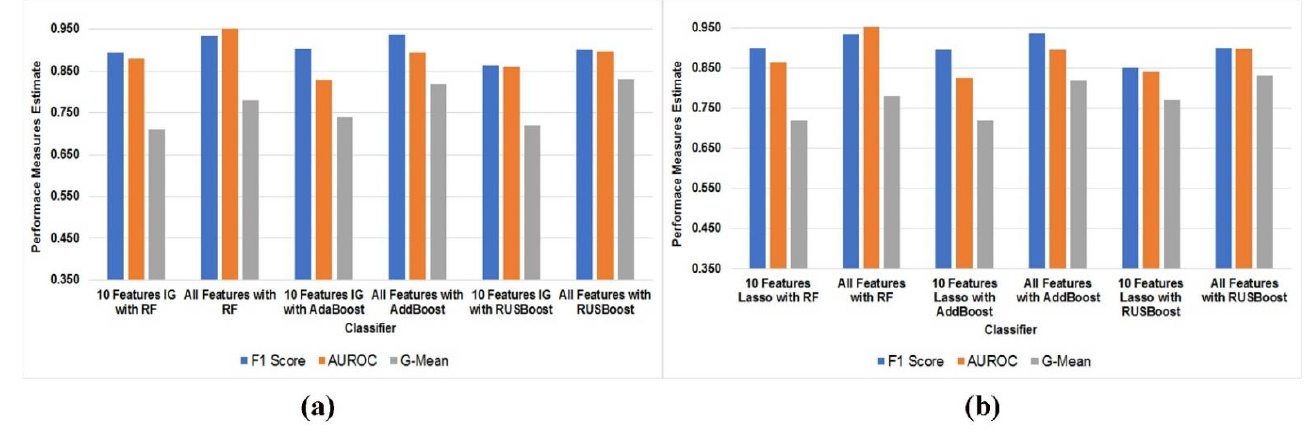
Figure 4. ( a , b ): Comparative evaluation of performance measures ( a ) F1-score ( b ) AUROC ( c ) G-Mean in models built using 10 features against all features set using information gain and lasso.